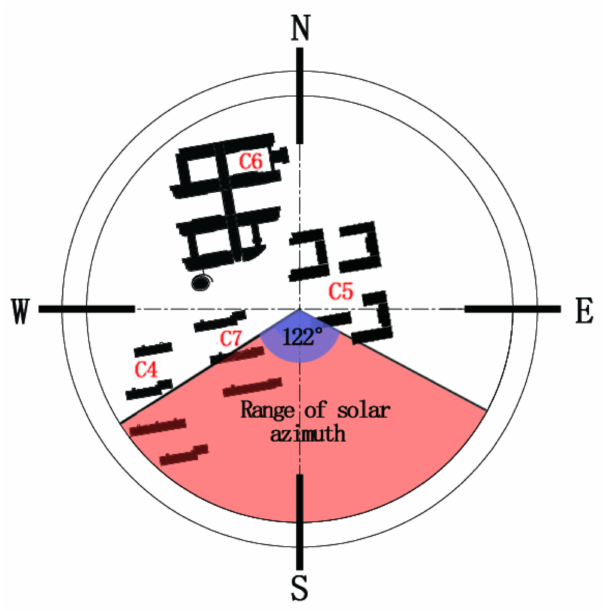
Figure 10. Relationship between locating directions of buildings and solar